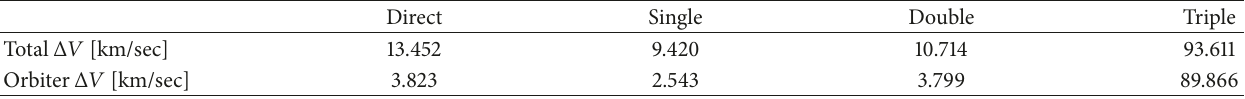
Table 6: Mission Δ𝑉 to Hylonome for multiple flyby scenarios.